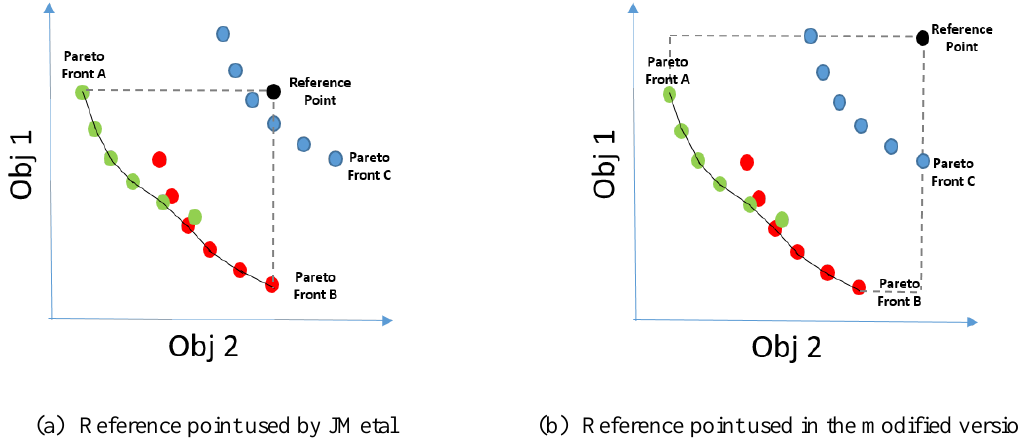
Figure 1. Reference points used for computing the RHV